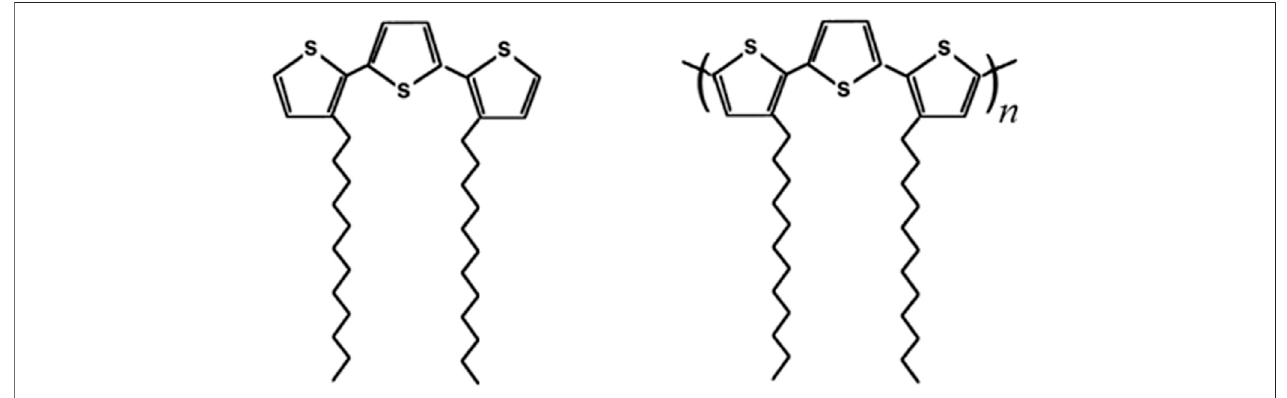
FIGURE 1 | Sketches of 3,3 ″ -DDTT (monomer on the left) and poly-3,3 ″ -DDTT (polymer on the right) . The monomer 3,3 ″ -DDTT has been employed as a precursor for the electrochemical deposition of the corresponding polymer poly-3,3 ″ -DDTT.